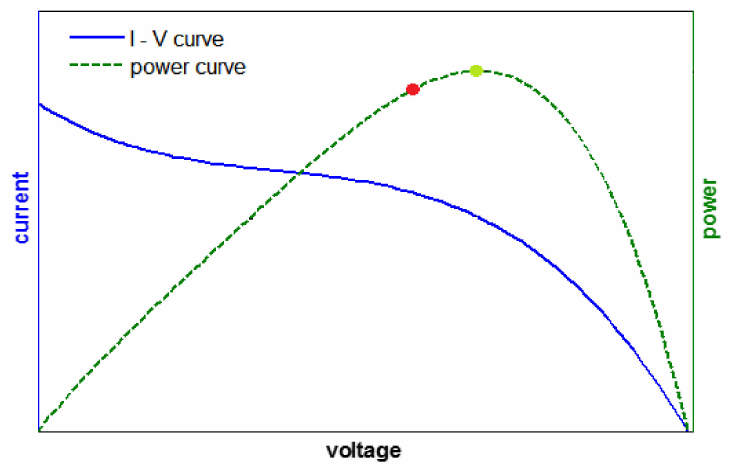
Figure 1. I–V and P–V curves of a generic fuel-based soft